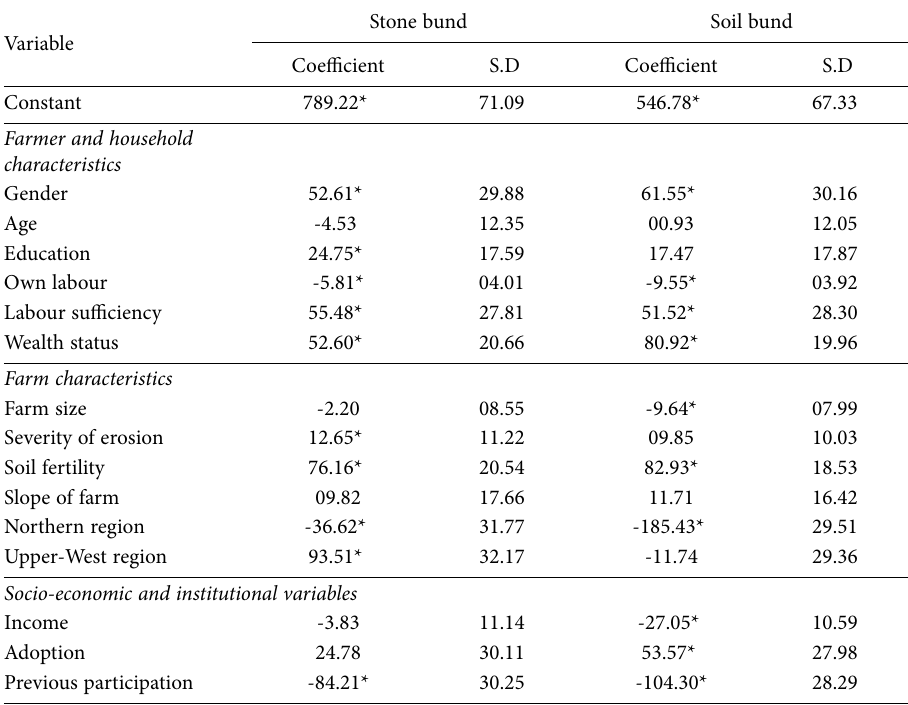
Table 6. Interval data model estimates on determinants of WTA/hectare for stone bund and soil bund. Stone bund Soil Variable